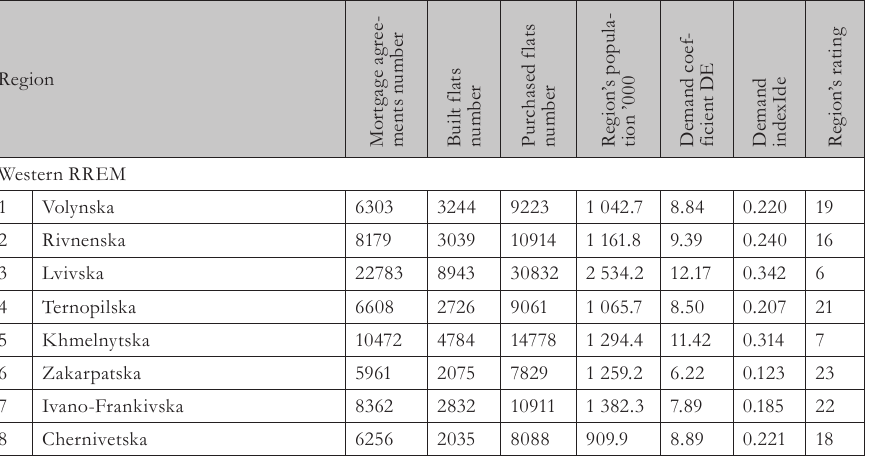
Tab. 1 – Housing demand of Ukraine regions according to their division into RREM, on January 1, 2017 (excluding the temporarily occupied territory of the Autonomous Republic of Crimea, the city of Sevastopol and parts of the area of anti-terrorist operation in Donetsk, Luhanska region). Source: State Statistics Service of Ukraine (2019), Ministry of Justice of Ukraine